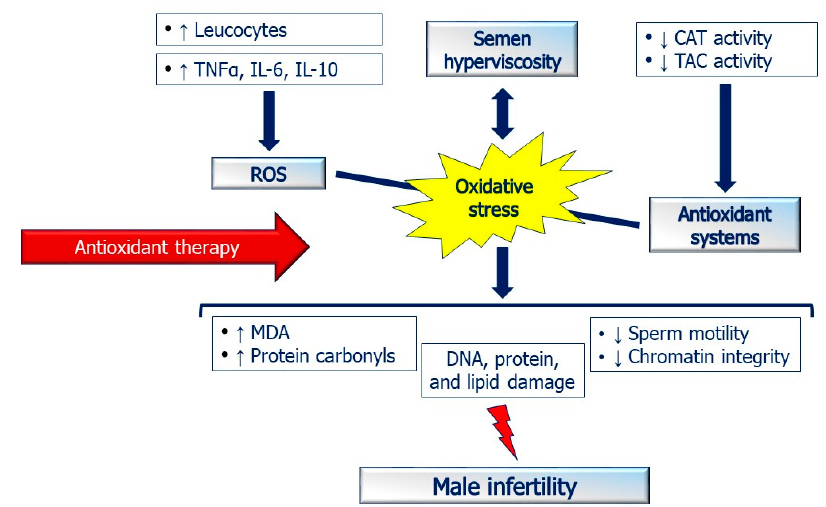
Figure 2. Seminal fluid hyperviscosity and oxidative stress. The mechanism by which hyperviscosity causes infertility is still poorly understood. Increased seminal fluid viscosity worsens sperm parameters, especially motility, and decrease chromatin integrity [35]. Interestingly, previous studies have shown an imbalance between oxidant production and antioxidant capacity in patients with high seminal fluid viscosity. A decreased activity of catalase (CAT) and total antioxidant capacity (TAC) have been reported in patients with hyperviscous ejaculates [8,62]. On the contrary, seminal fluid hyperviscosity correlated to increased levels of malondialdehyde (MDA) and protein carbonyls [63], high levels of pro-inflammatory interleukins, and leukocytes [19]. The increased oxidative stress damages DNA, proteins, and lipids and in turn, impairs male fertility. Thus, a careful assessment of oxidative stress in patients with hyperviscosity may be very useful in clinical practice. Infertile patients with seminal fluid hyperviscosity could benefit from the treatment with antioxidants to protect sperm cells from oxidative damage and to improve their functional properties.